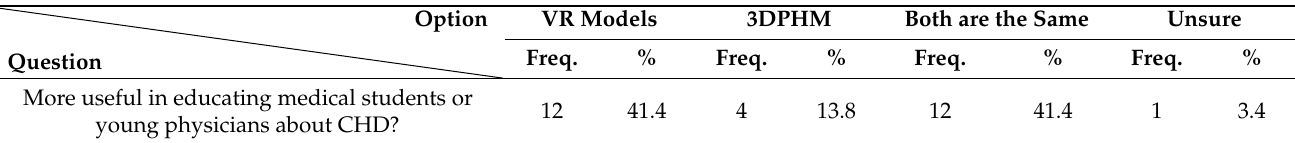
Table 3. Participants’ responses on the utility of VR and 3DPHM in educating medical students or young physicians about complex CHD.